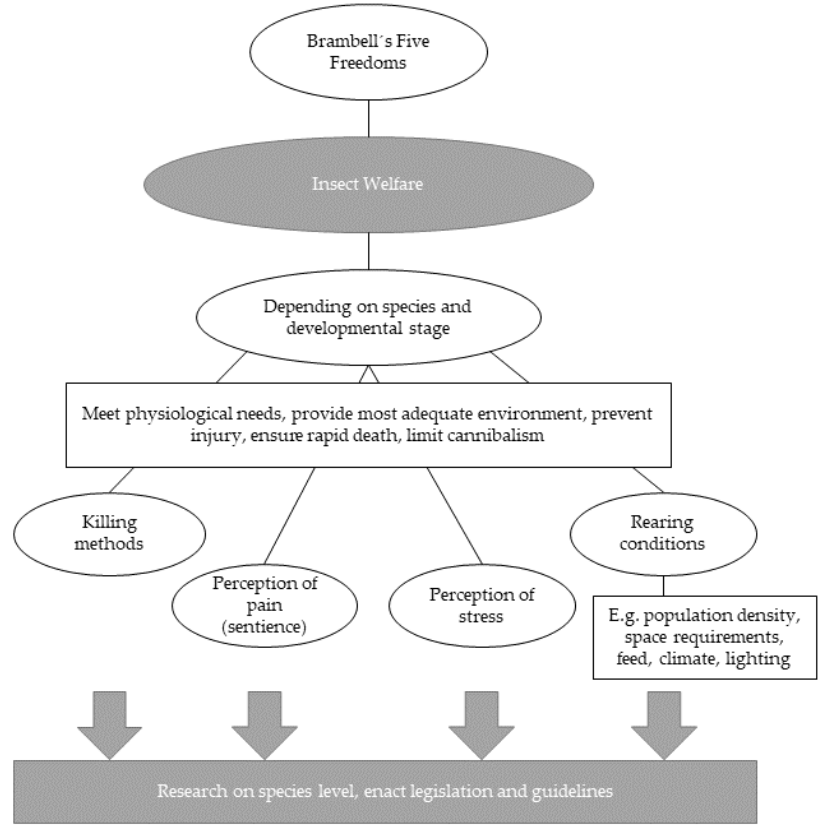
Figure 1. Summary of insect welfare aspects based on the Five Freedoms [27,28].